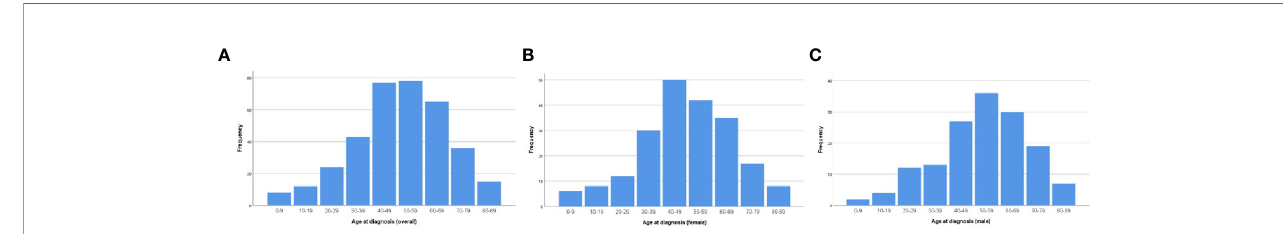
FIGURE 2 | Age distribution of the patients at diagnosis: (A) for the whole cohort; (B) for female patients; (C) for male patients.